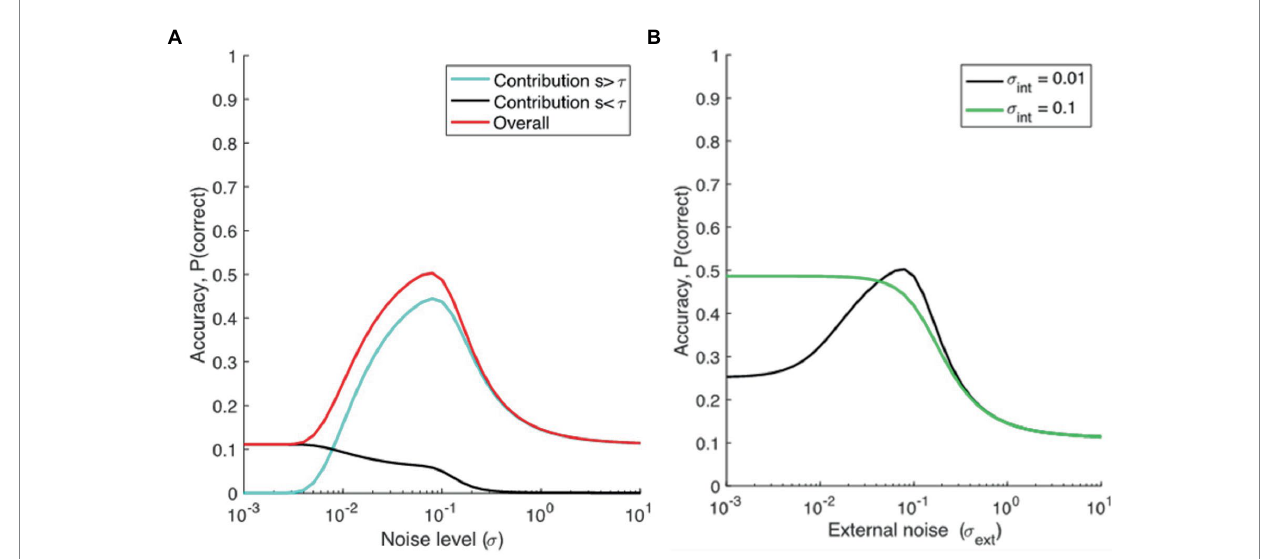
FIGURE 1 (A) Modeling proportion correct dependent on noise. M = 9, τ = 0.2, s = 0.19, σ int = 0, σ ext is varied, and (B) the dependence of accuracy ( Pc ) on external noise ( σ ext ), assuming different levels of internal noise for two groups, a low-noise group (representing TD individuals, or TD individuals with lower AQ scores, σ int = 0.01), and a high noise group (representing ASD, or TD individuals with higher AQ scores, σ int =